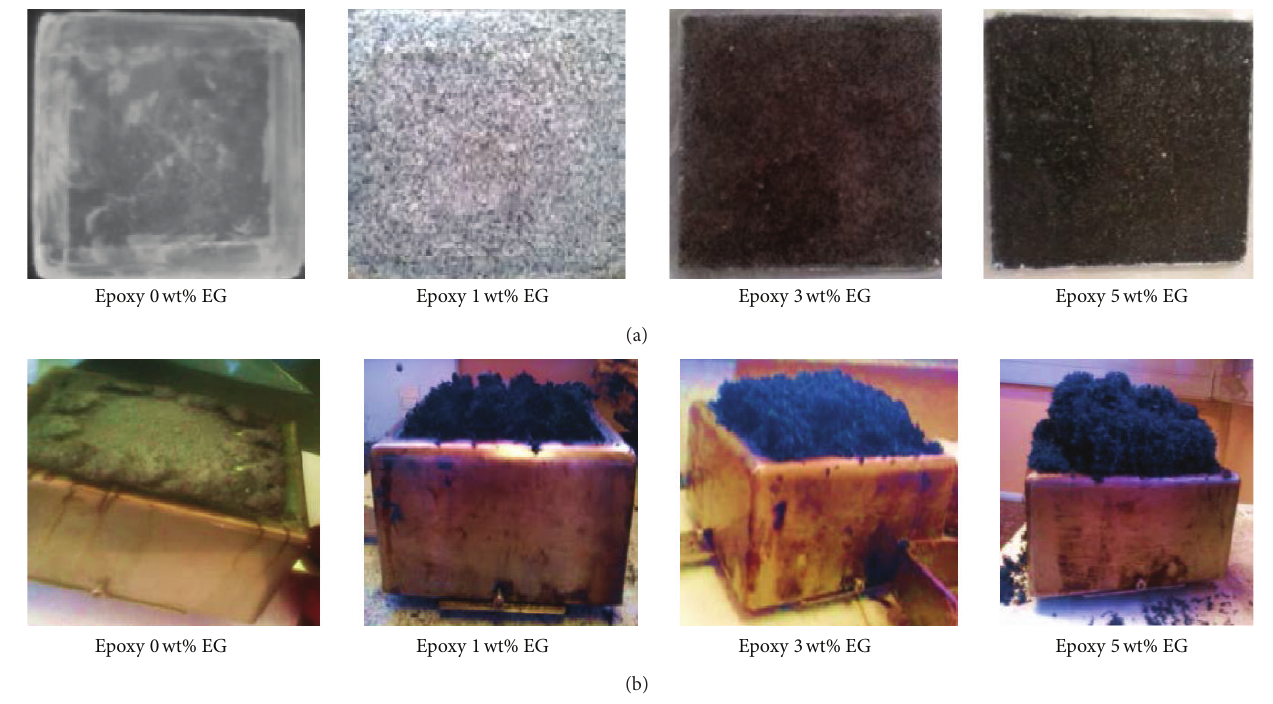
Figure 1: Before (a) and after (b) Cone Calorimeter measurements of the epoxy-EG samples.